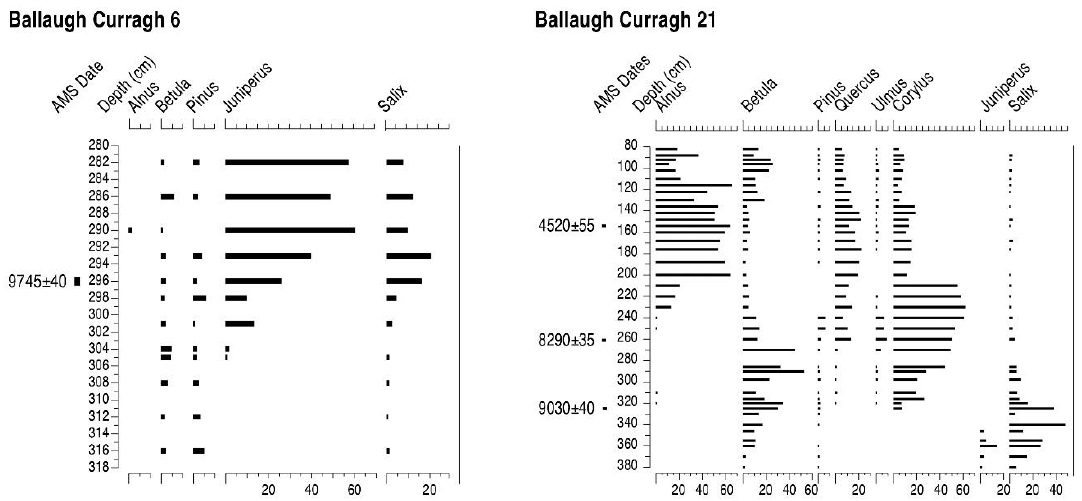
Figure 6. Percentage pollen diagrams from Ballaugh Curragh 6 and Ballaugh Curragh 21, Isle of Man, showing selected tree taxa and 14 C BP AMS ages.